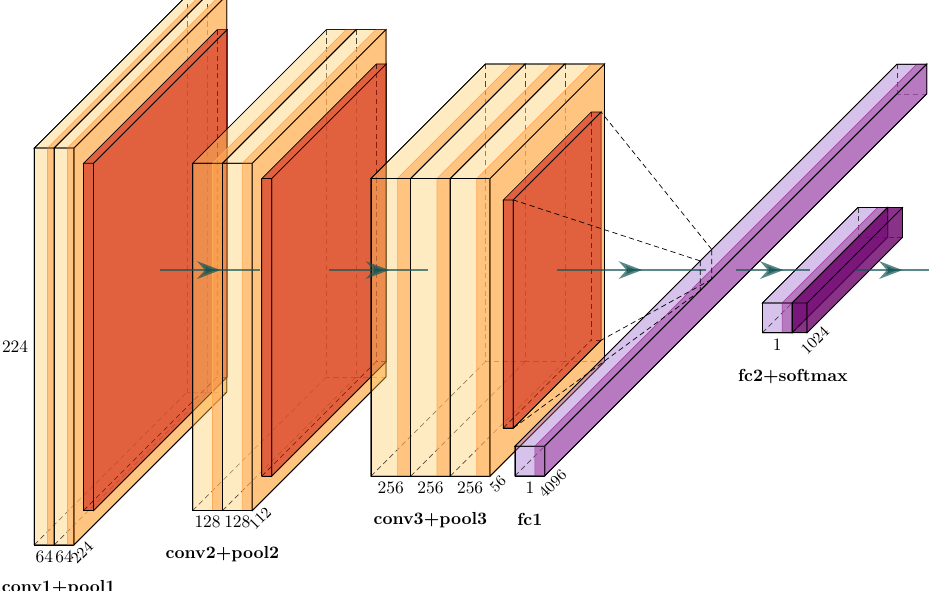
Figure 7. CNN structure for NLOS signal